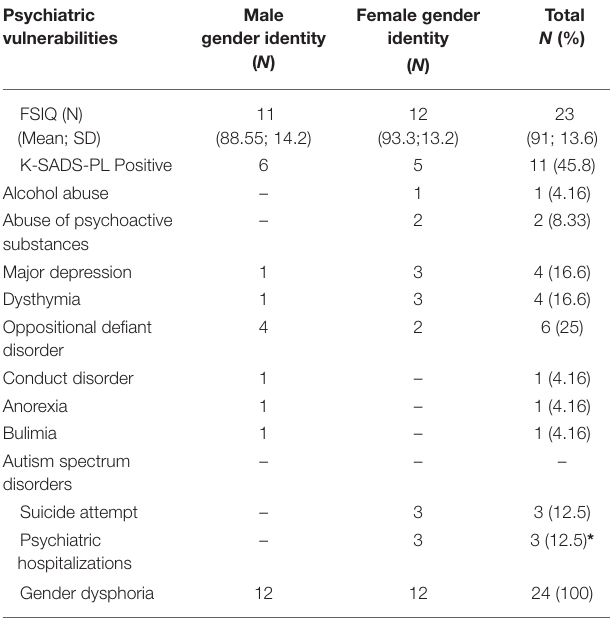
TABLE 4 | Occurrence of psychiatric vulnerabilities and diagnosis status in the present and/or past lifetime and full-scale